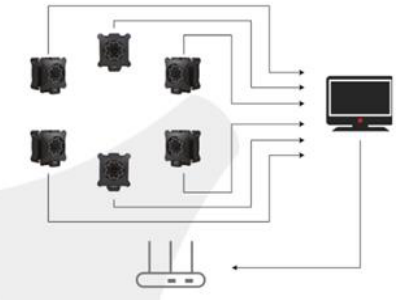
Figure 1. Structure of the Nokov system.